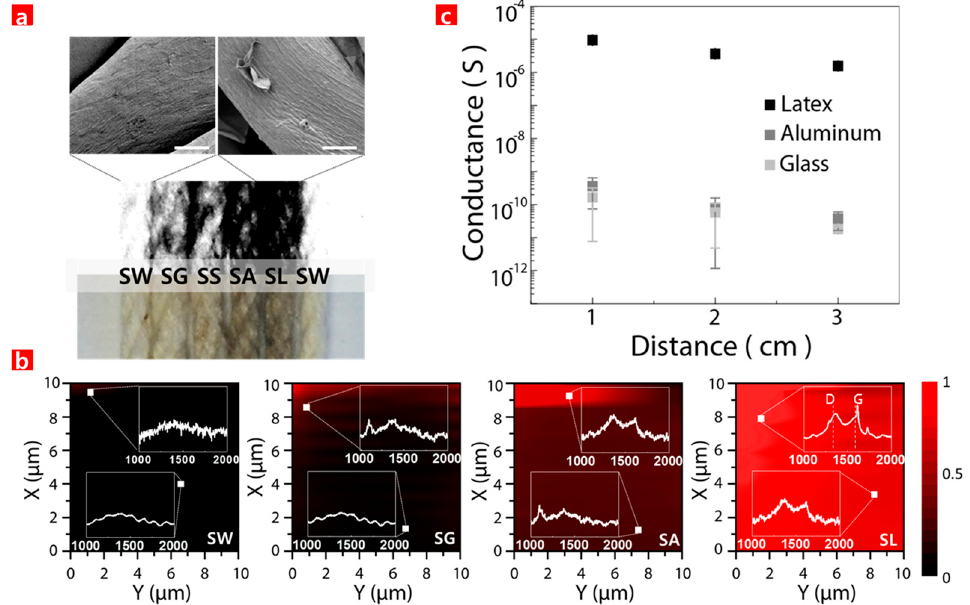
Figure 2. ( a ) Optical images of various GO-coated SFs, and SEM image of SW and SL (scale bar 10 µ m); ( b ) Raman mapping image of SW, SG, SA, and SL, respectively; ( c ) Conductance of GO-coated SFs (SG, SA, and SL).